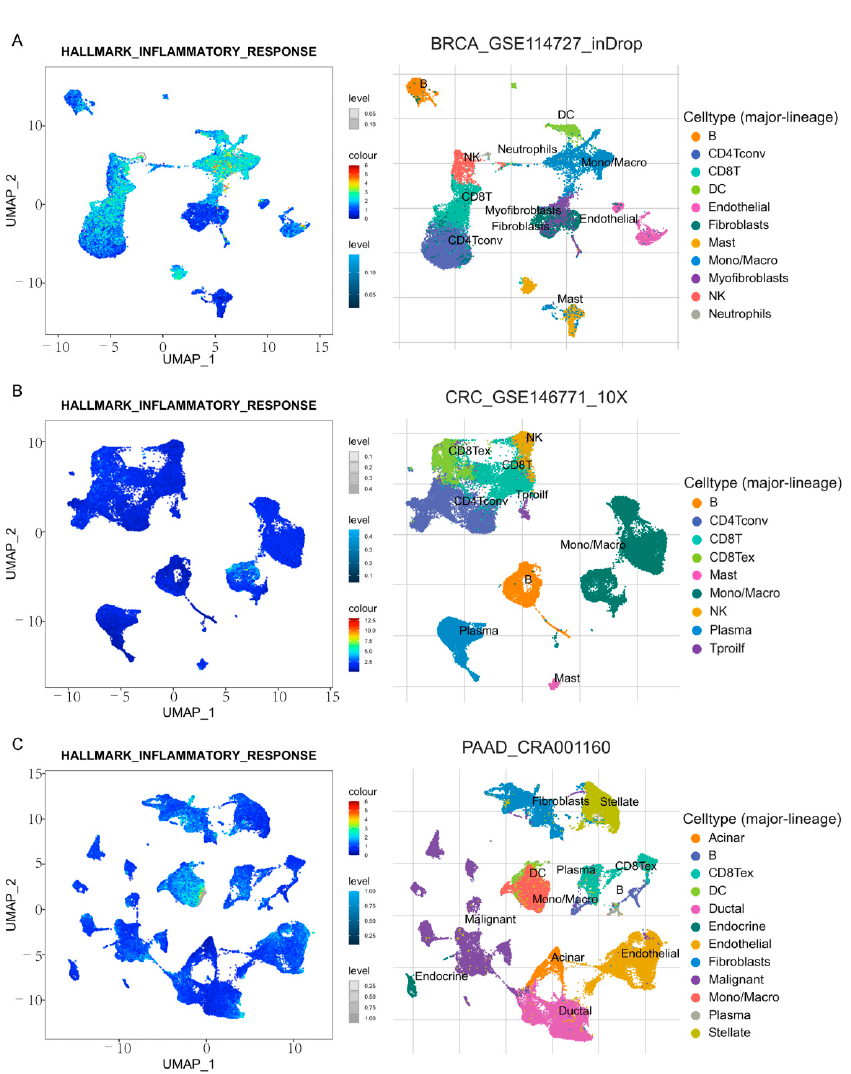
Figure 15. Computing and visualizing GSEA pathway enrichment score of inflammatory response (TISCH). Enrichment analysis in BRCA ( A ), COAD ( B ), and PDAC( C ) patients. 3.9. Immune Cell Infiltration and CXCs in Three Types of Cancer At present, the function of CXCs is still controversial. Some studies have found that tumor cells secrete CXCs to act on their own surface receptors [28], while other studies have revealed that CXCs can act as a signal to recruit immune cells [29]. The results of the functional enrichment and pathway analyses suggest that CXCs may influence the clinical outcome of cancer patients through regulating inflammatory response and immune cell infiltration. Therefore, we used the TIMER database to explore specific features of CXCs. We analyzed the correlations between each CXC and tumor purity, B cells, CD8 + T cells, CD4 + T cells, macrophages, neutrophils, and dendritic cells in three types of cancer. A total of 244 pairs with significant correlation were detected, including 24 pairs with a partial correlation coefficient (Partial.cor) > 0.5; all pairs were positively correlated. As